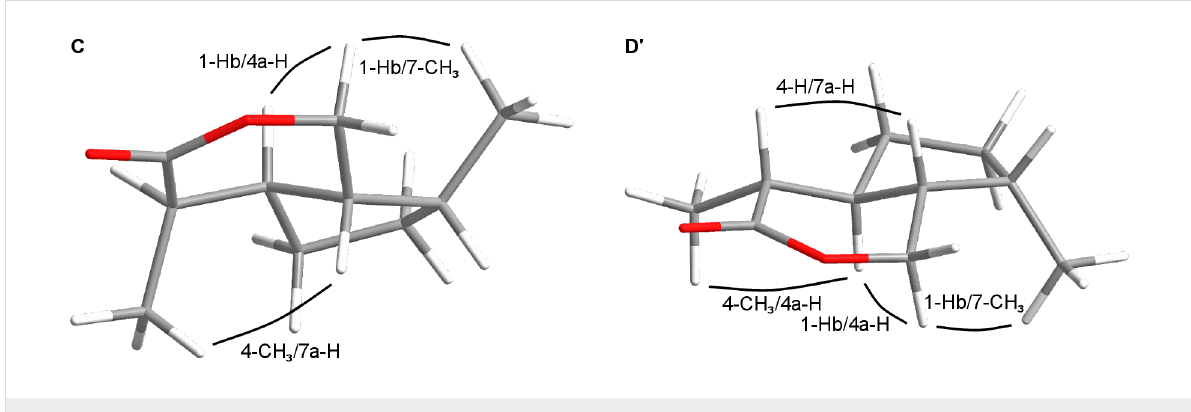
Figure 6: Configurations of the trans -fused iridomyrmecins C and D’